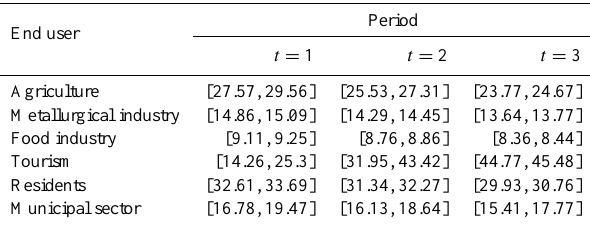
Table 5. Water allocations to end users (million m 3 ) .